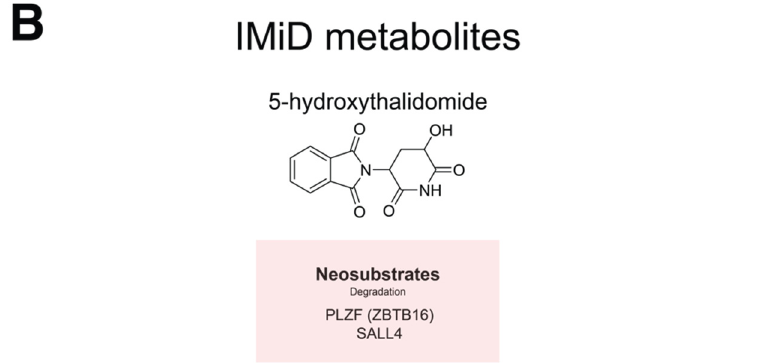
Figure 2. Structure of IMiDs and their reported substrate repertoires. ( A ) Chemical structures of thalidomide, lenalidomide and pomalidomide. Endogenous CRBN substrates that are stabilized or re-localized upon treatment with each of these molecules are listed in the blue panels. CRBN clients, whose maturation/stability is modulated by the respective IMiDs are listed in the green panels. CRBN neosubstrates are listed within the red panels. ( B ) The structure of thalidomide metabolite, 5-hydroxythalidomide and its demonstrated neosubstrates.